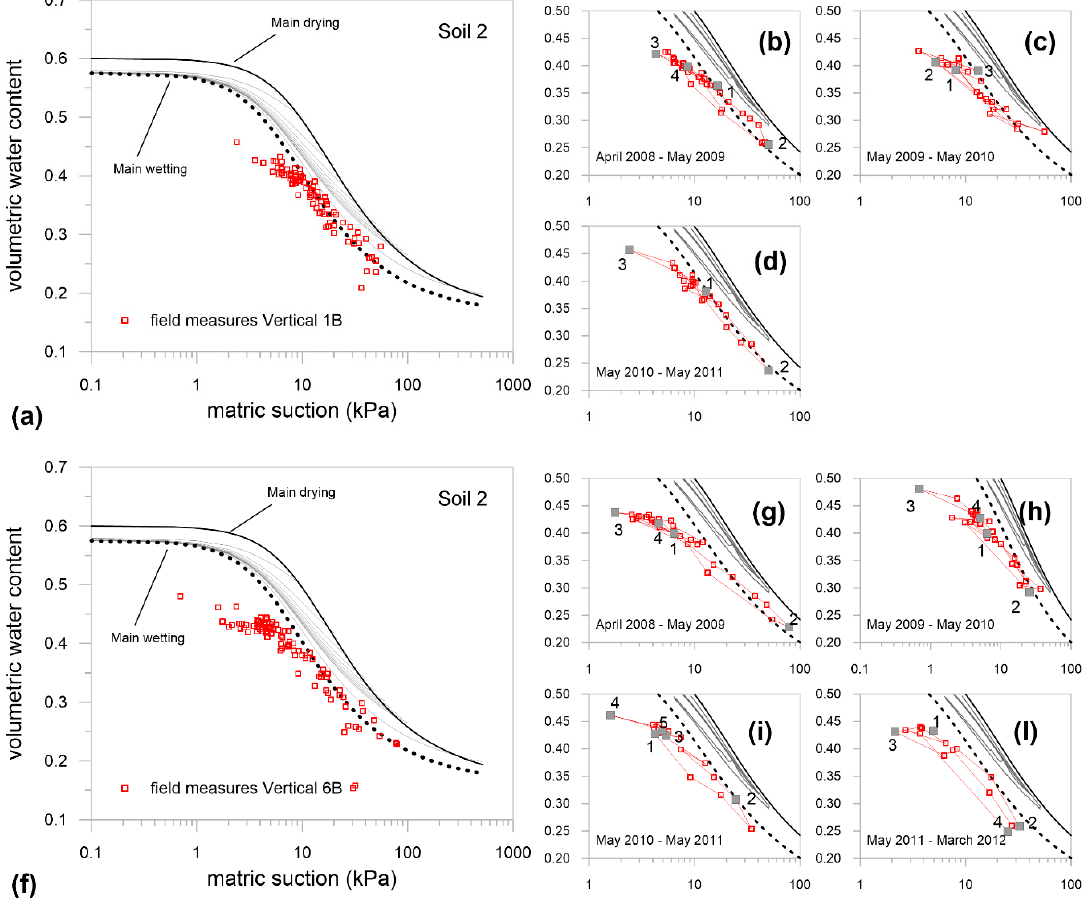
Figure 13. Pairs of matric suction and water content measurements collected at the site in soil 2 along verticals ( a ) 1B and ( f ) 6B compared to the main loop (continuous and dotted black lines) and to the secondary wetting paths starting from different points on the main drying curve (gray dotted lines). Field paths grouped by year and detected at vertical 1B ( b) –( e ) and at vertical 6B ( g )–( l ) compared to experimental path measured in the lab (test F).